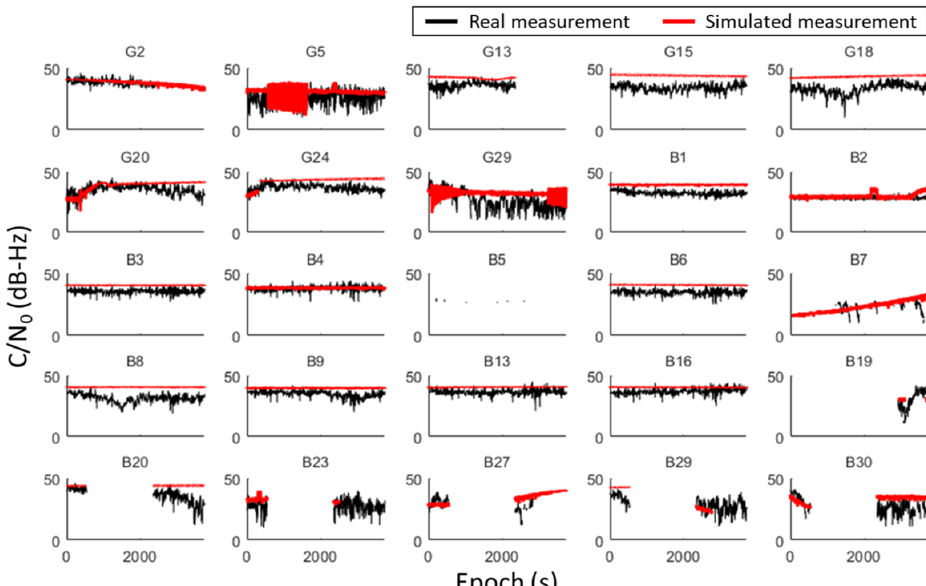
Figure 14. The simulated C / N 0 and corresponding real measurements from each satellite during the long-period static experiment. The notation below each subfigure denotes the index of each satellite from different constellation, where ‘G’ —GPS; ‘B’—Beidou.